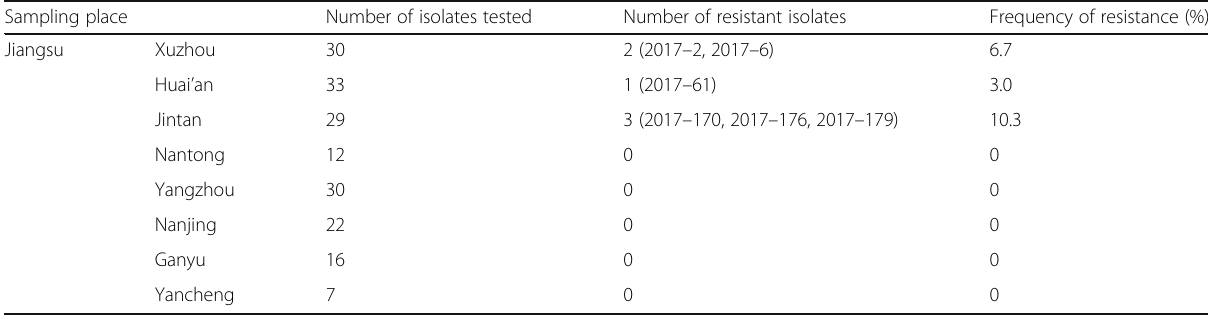
Table 1 Frequency and distribution of resistance of Ustilaginoidea virens to propiconazole in 2017 Sampling place Number of isolates